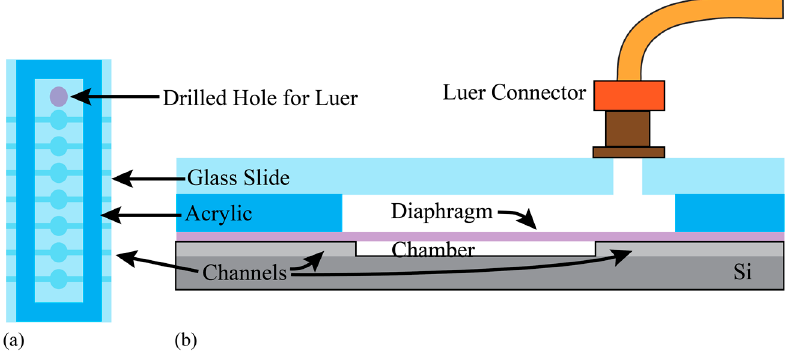
Figure A2. Illustration of cross-section of test fixture for testing diaphragm deflection. Visual inspection with Wyko interference microscope allows for correlation between actuation pressure and deflection at the center of the diaphragm for comparison to theory. ( a ) Top view showing pneumatic access, plenum, and underlying chamber; ( b ) Illustration of plenum/chamber arrangement, (pneumatic access shown out of position for clarity).